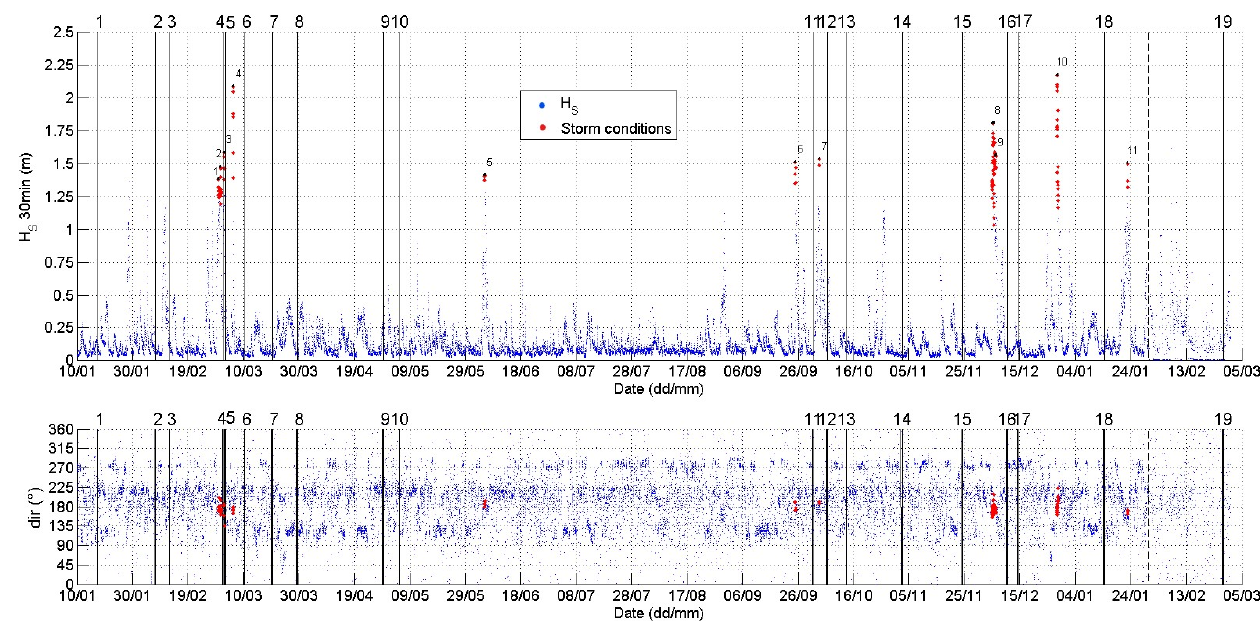
Figure 7. Identified storm events. A dashed line represents the stop of the wave buoy measurement and the start of the ADCP data (30 January 2021).